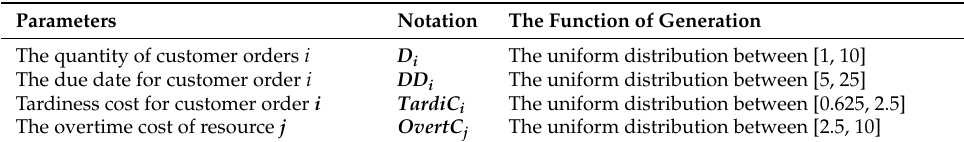
Table 1. Parameter adjustment.